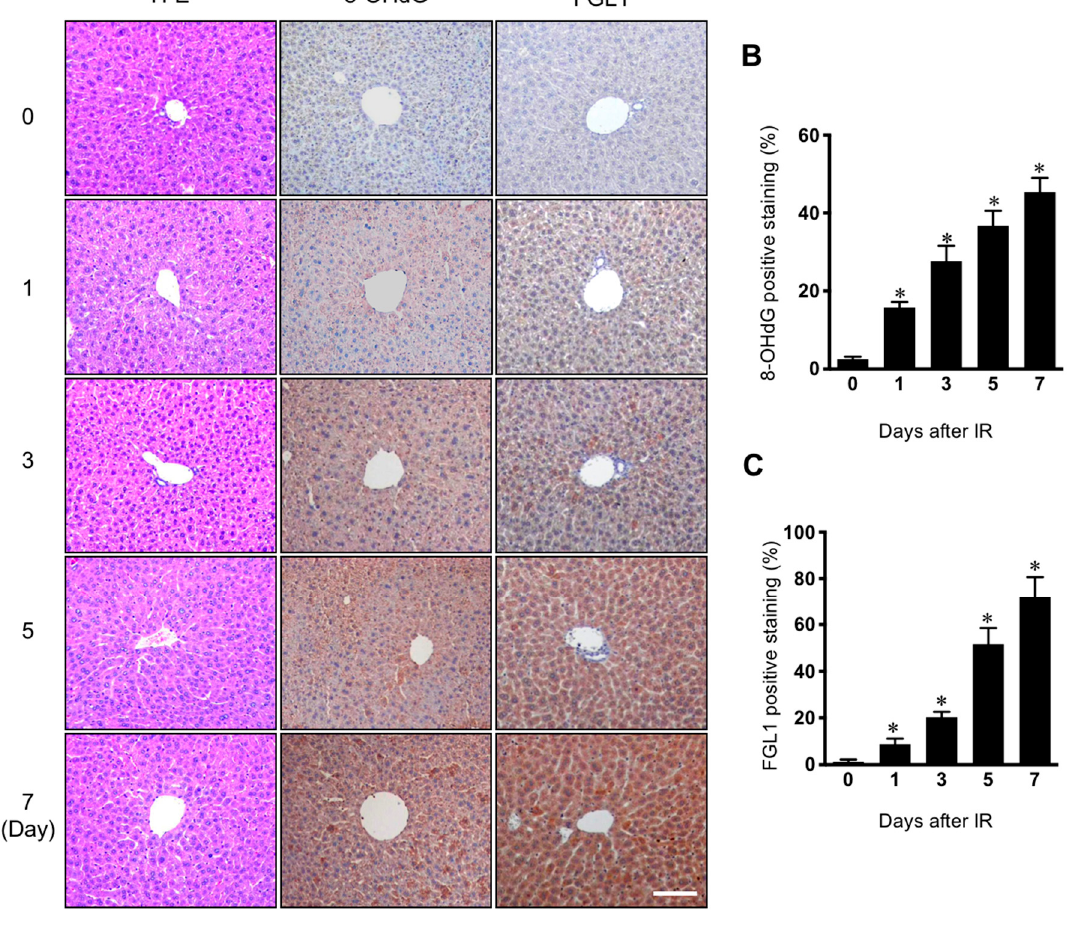
Figure 2. Expression of 8-OHdG and FGL1 in the liver following 30 Gy of whole liver irradiation. ( A ) Liver section stained at various days after IR. Hematoxylin-eosin (H–E), FGL1, and 8-hydroxy-2 ′ -deoxyguanosine (8-OHdG) expression in the liver was determined by immunohistochemistry. Scale bar: 100 µ m. ( B , C ) Quantification of the positive signal of FGL1 and 8-OHdG in a unit area at the indicated. Data represented Mean ± SD (n = 5, * p < 0.05 vs. the day 0 control).